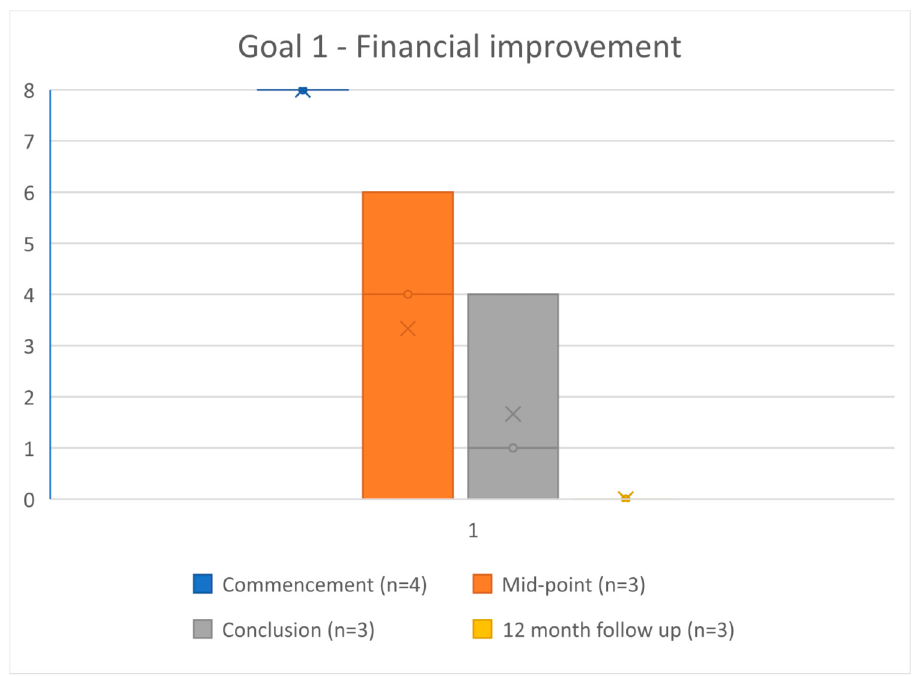
Figure 4. Goal 1—Financial improvement, where 0 = goal is achievable, 8 = goal is not achievable.